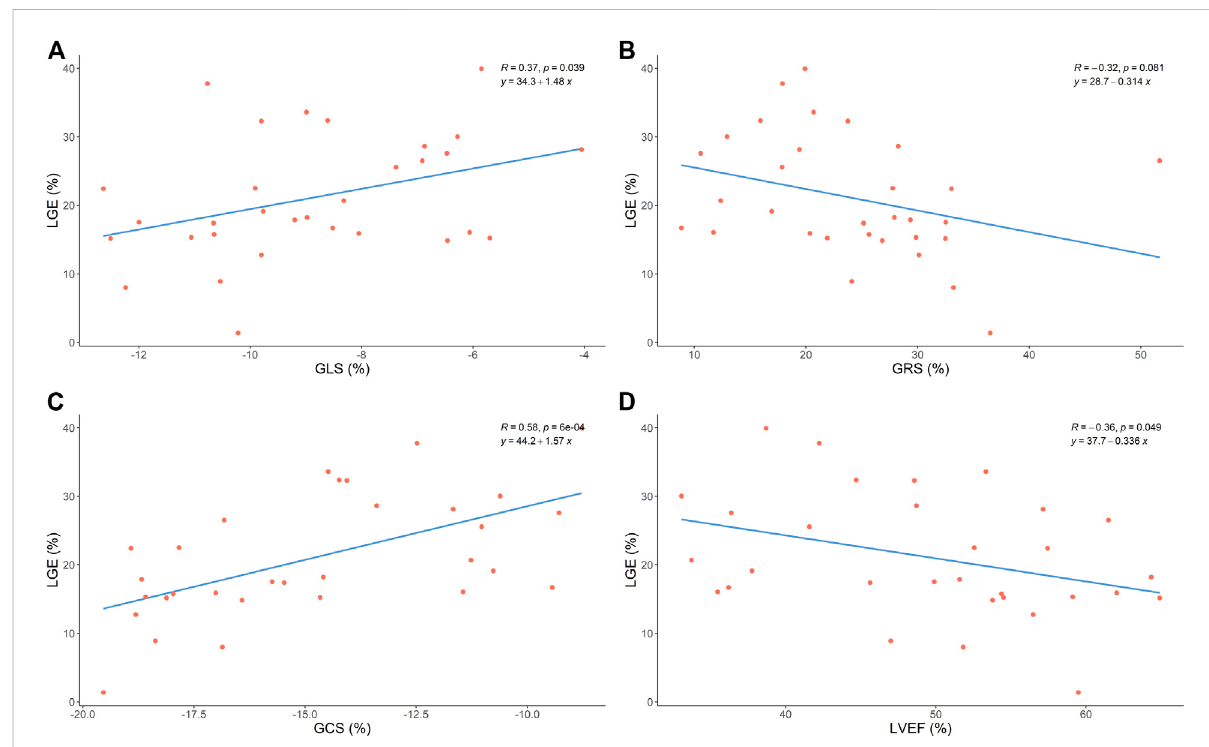
FIGURE 3 Correlationbetweenglobalstrain,LVEFandLGEsize.GLS,globallongitudinalstrain;GRS,globalradialstrain;GCS,globalcircumferentialstrain; LVEF, left ventricular ejection fraction; LGE, late gadolinium enhancement.